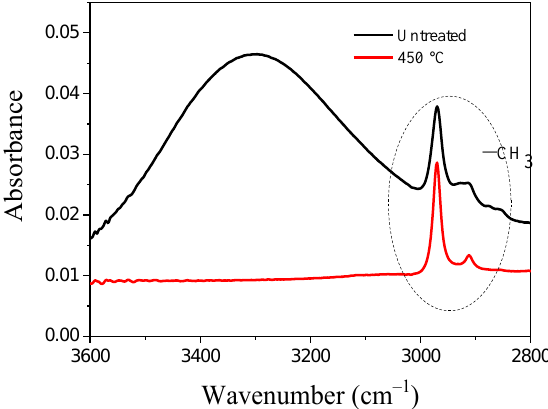
Figure 4. FT-IR measurement of TSC on soda-lime glass. The processing temperature of 450 °C was not sufficient to mineralise the siloxane because the methyl groups are still present after thermal treatment.